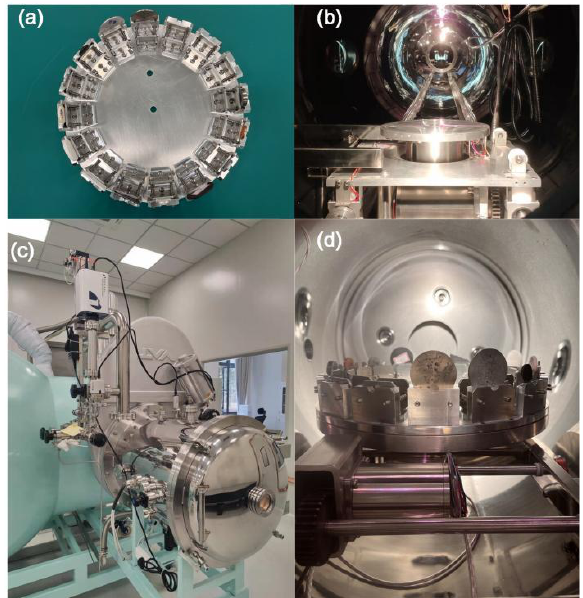
Figure 4. ( a ) The sample plate with 16 sample seats. ( b ) The 3D vacuum stage and the track. ( c ) The external appearance of the sample import chamber. ( d ) The internal appearance of the sample im- port chamber, with the sample plate placed on the sample delivery